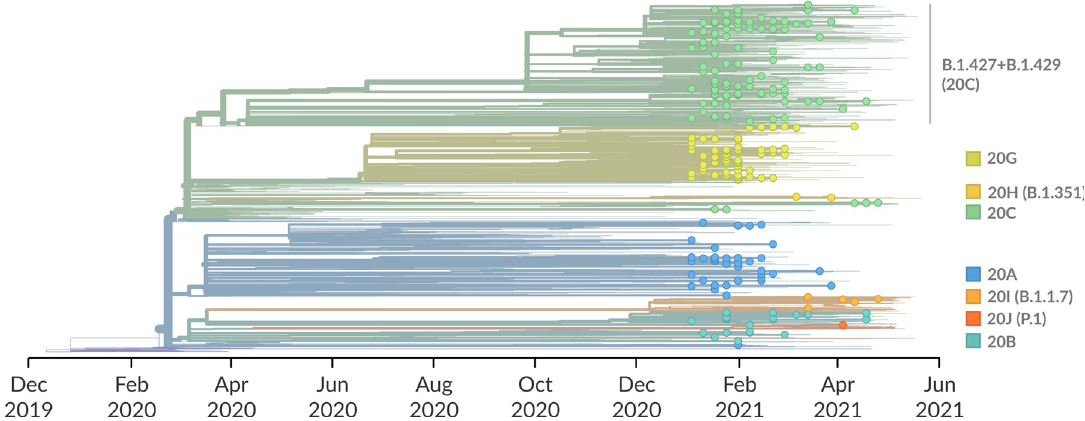
Fig 1. Temporally-resolved phylogenetic tree of 2519 SARS-CoV-2 whole genomes colored by Nextstrain clade designation. The genome sequences generated as part of this study are indicated with circles at the tips. Background sequences are indicated solely by their branch length. Nextrain clade designations, and their counterpart Pango lineages for key clades, are shown to the right of the